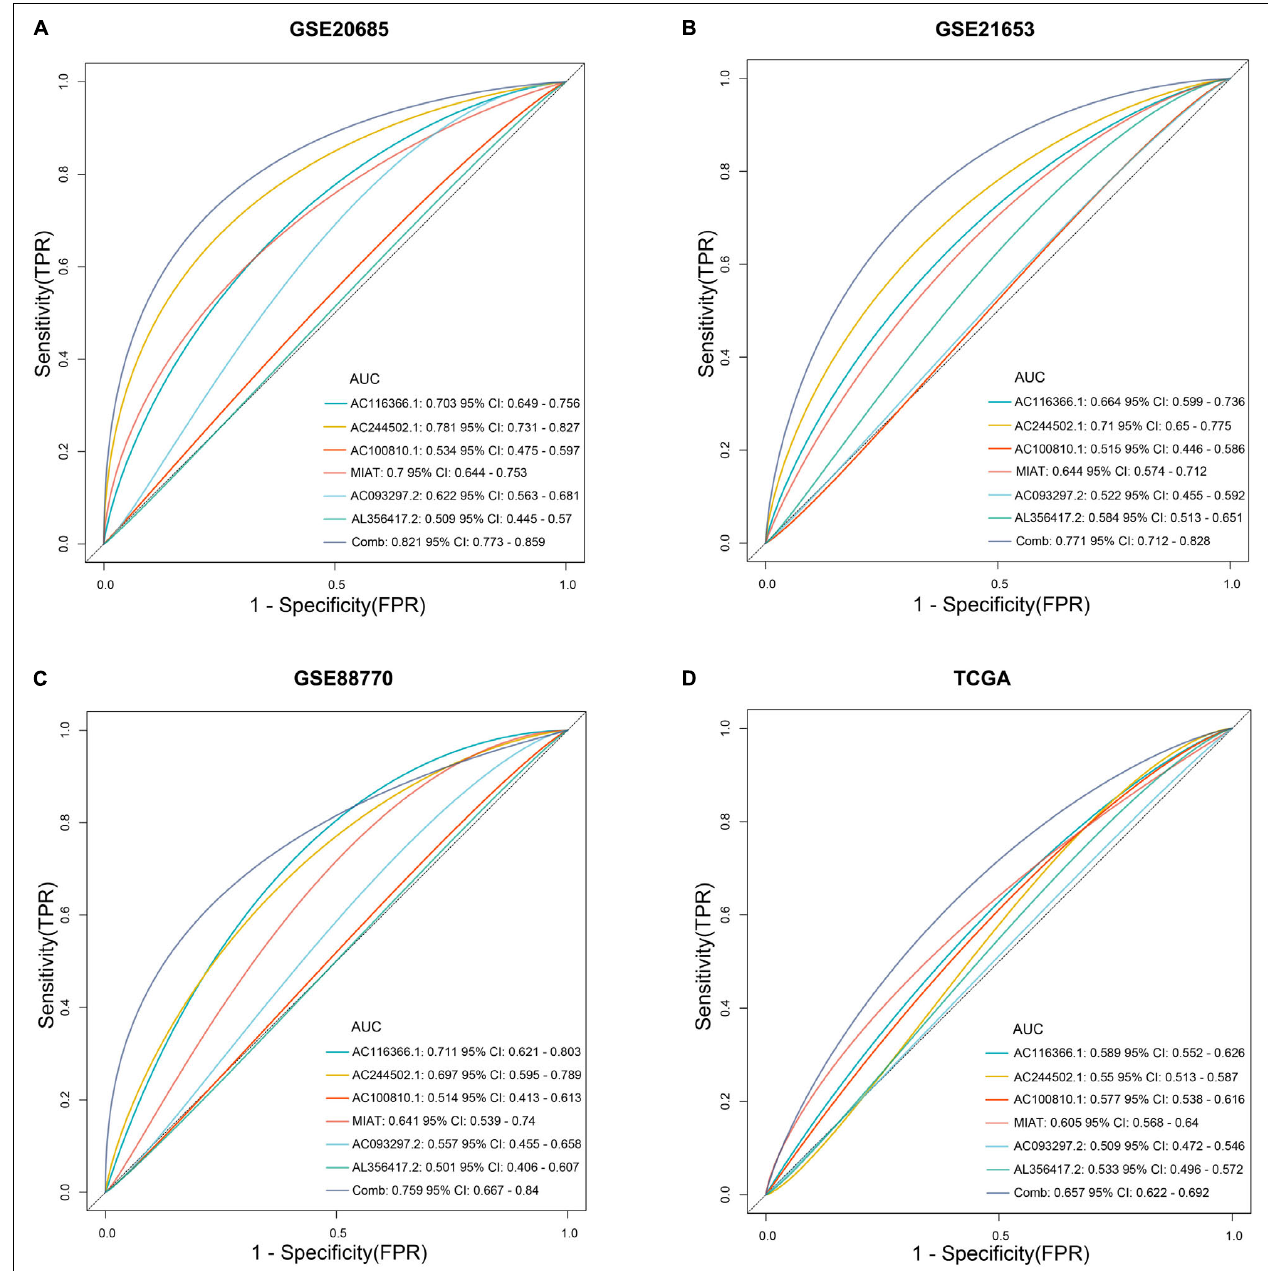
FIGURE 7 | The predictive efficacy of the six-lncRNA signature for infiltration of CD8 T cells. (A–D) Logistic regression was conducted to evaluate the predictive efficacy of the combination of the six lncRNAs and each lncRNA alone on the basis of the AUC value in training and validation sets.